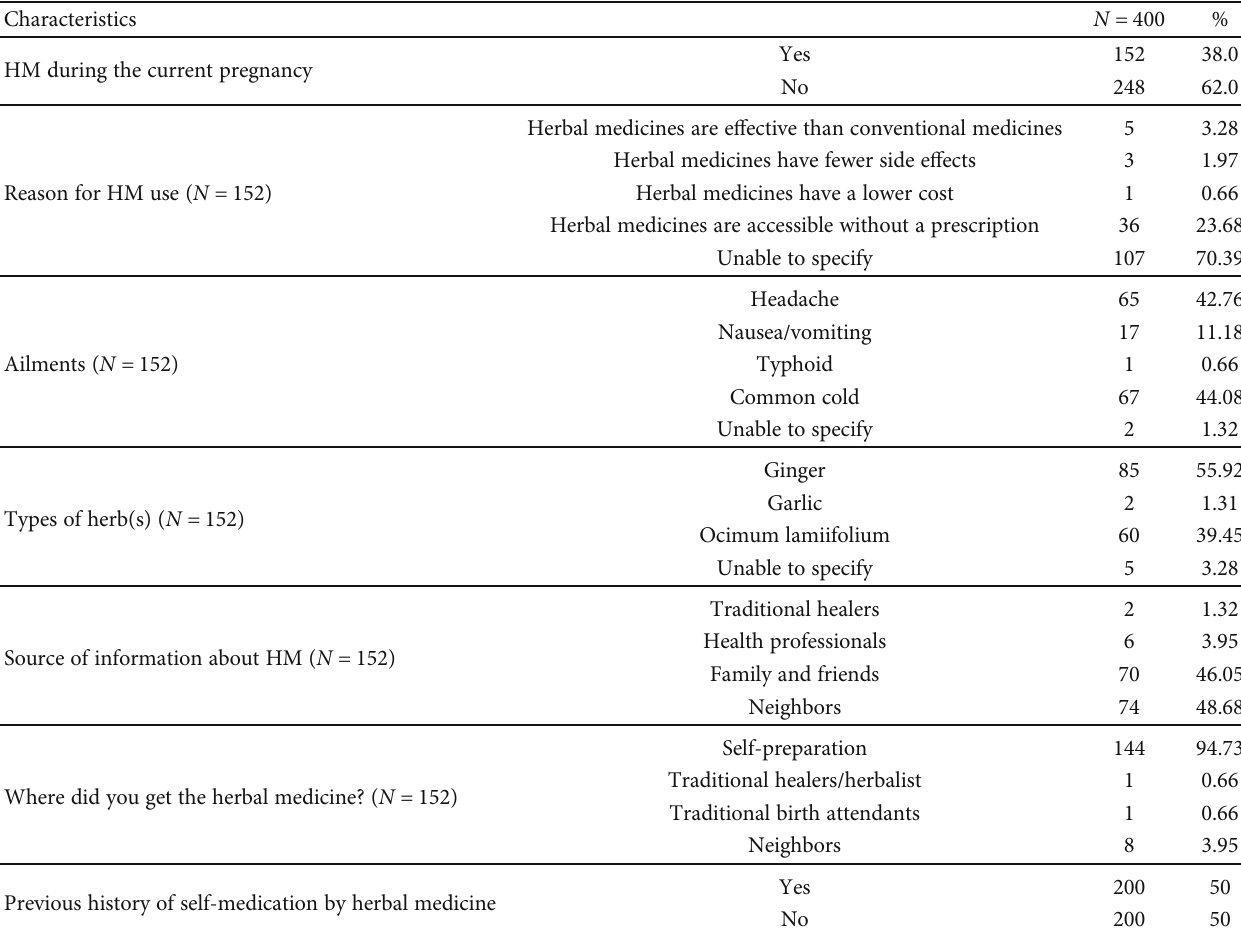
Table 5: Self-medication among pregnant women by using herbal medicine at UoGCSH, June 2019.